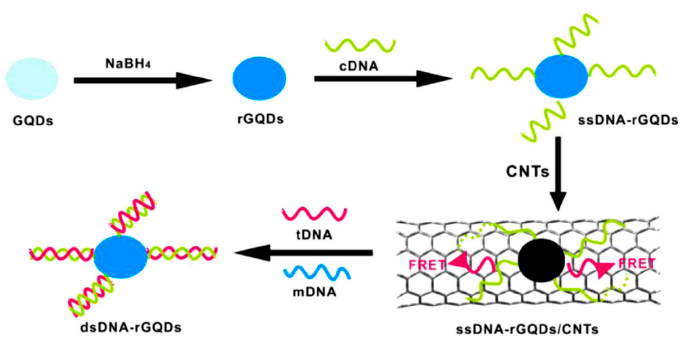
Figure 15. Schematic illustration of the DNA detection principle. Reproduced with permission from reference [76], Biosensors and Bioelectronics; published by Elsevier B. V., 2014.